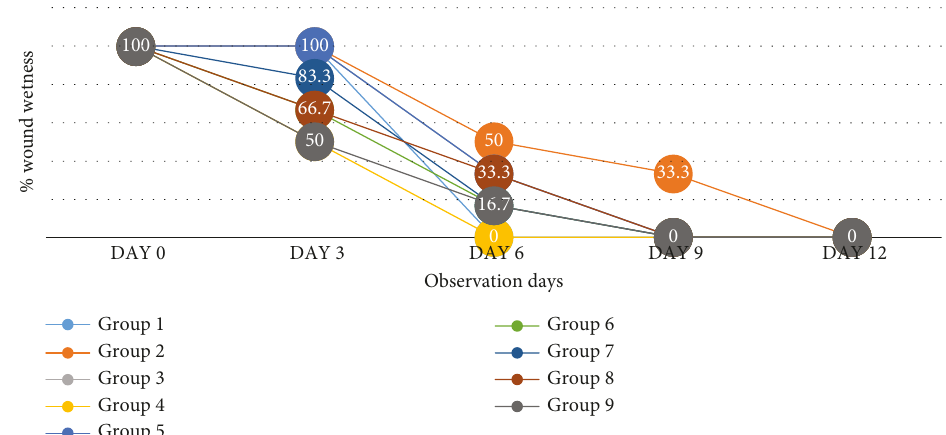
Figure 5: Percentage of wound exudation in experimental groups on days 3, 6, 9, and 12 after